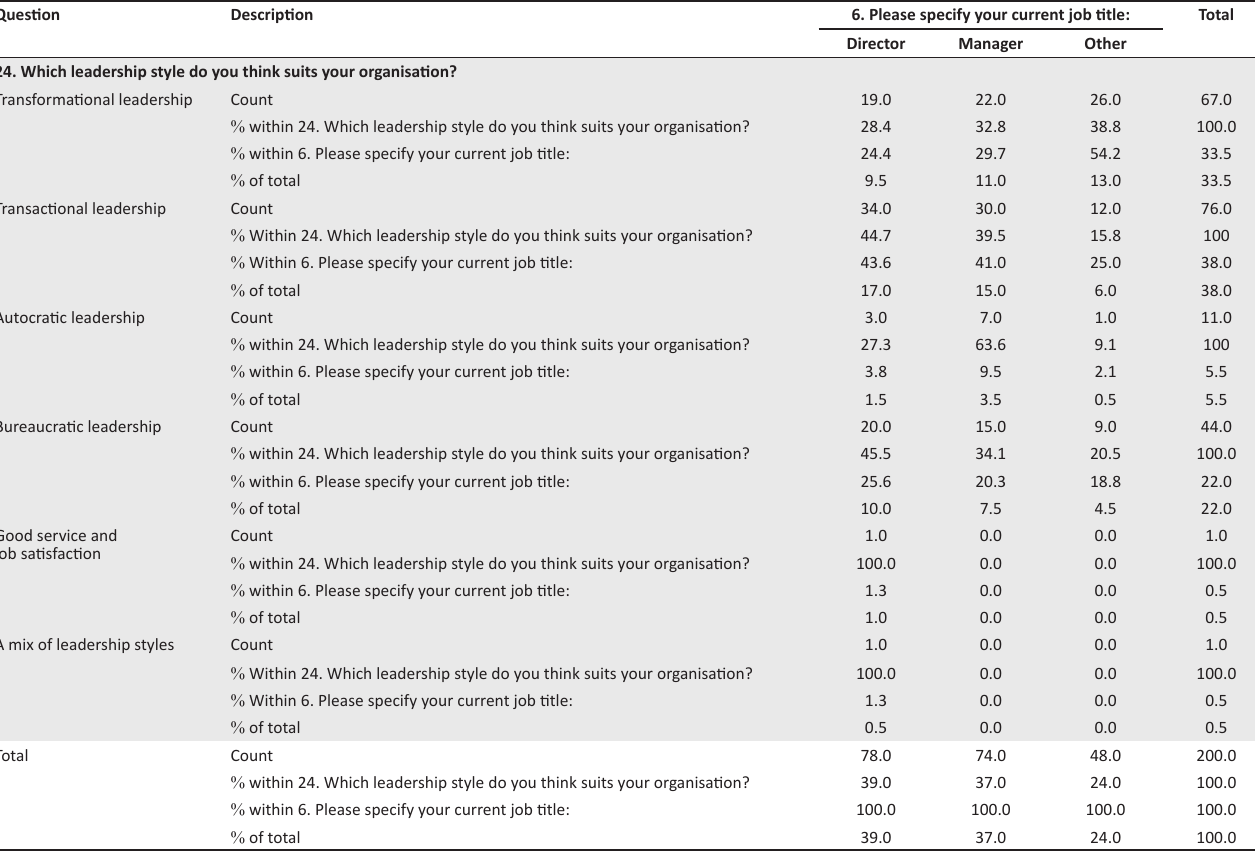
TABLE 3: Job title and leadership style (SPSS™/®/© version 27). Question Description